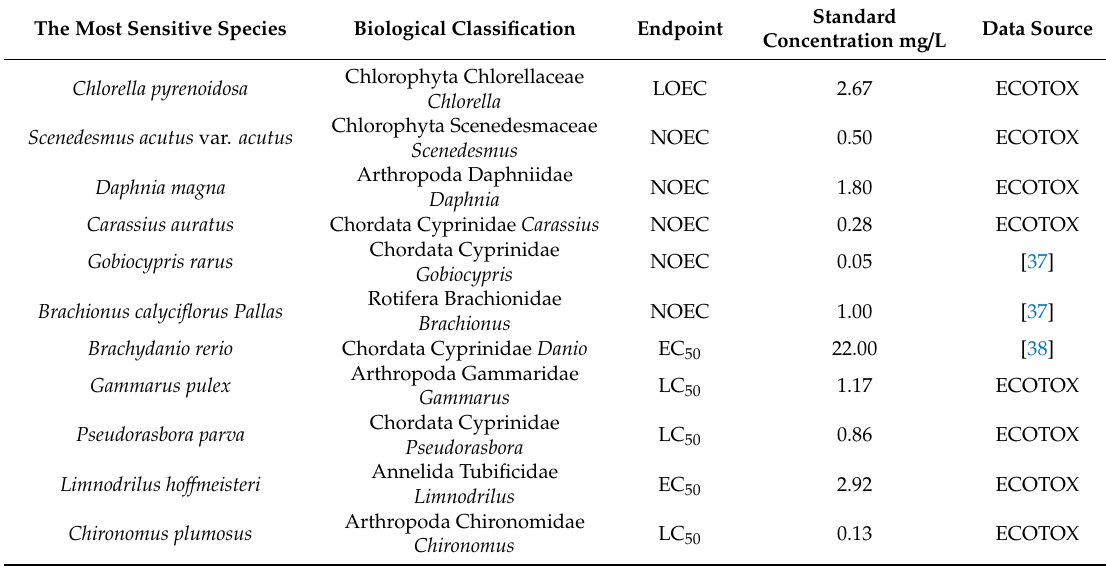
Table 4. Chronic toxicological data of